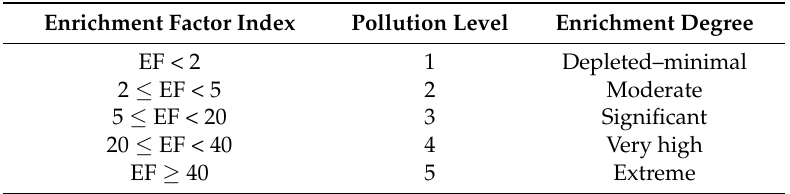
Table 1. Pollution evaluation criteria of the enrichment factor